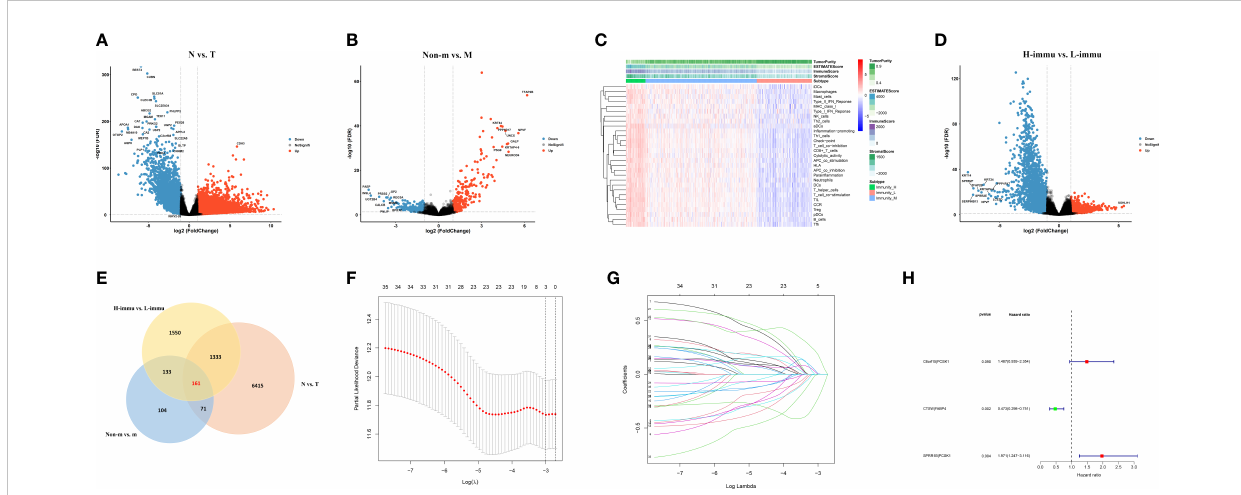
FIGURE 2 Prognostic signature construction. (A, B) Differential expression analysis for N vs . T, non-metastatic vs . metastatic of TCGA-CRC data; (C) ssGSEA analysis showing immunity cluster of CRC patients; (D) differential expression analysis for high- vs . low-immunity groups; (E) differential expression genes intersection of the three groups; (F, G) differentially expressed gene pairing and LASSO regression for prognostic signature construction; (H) forest plot for the three gene pairs comprising the risk